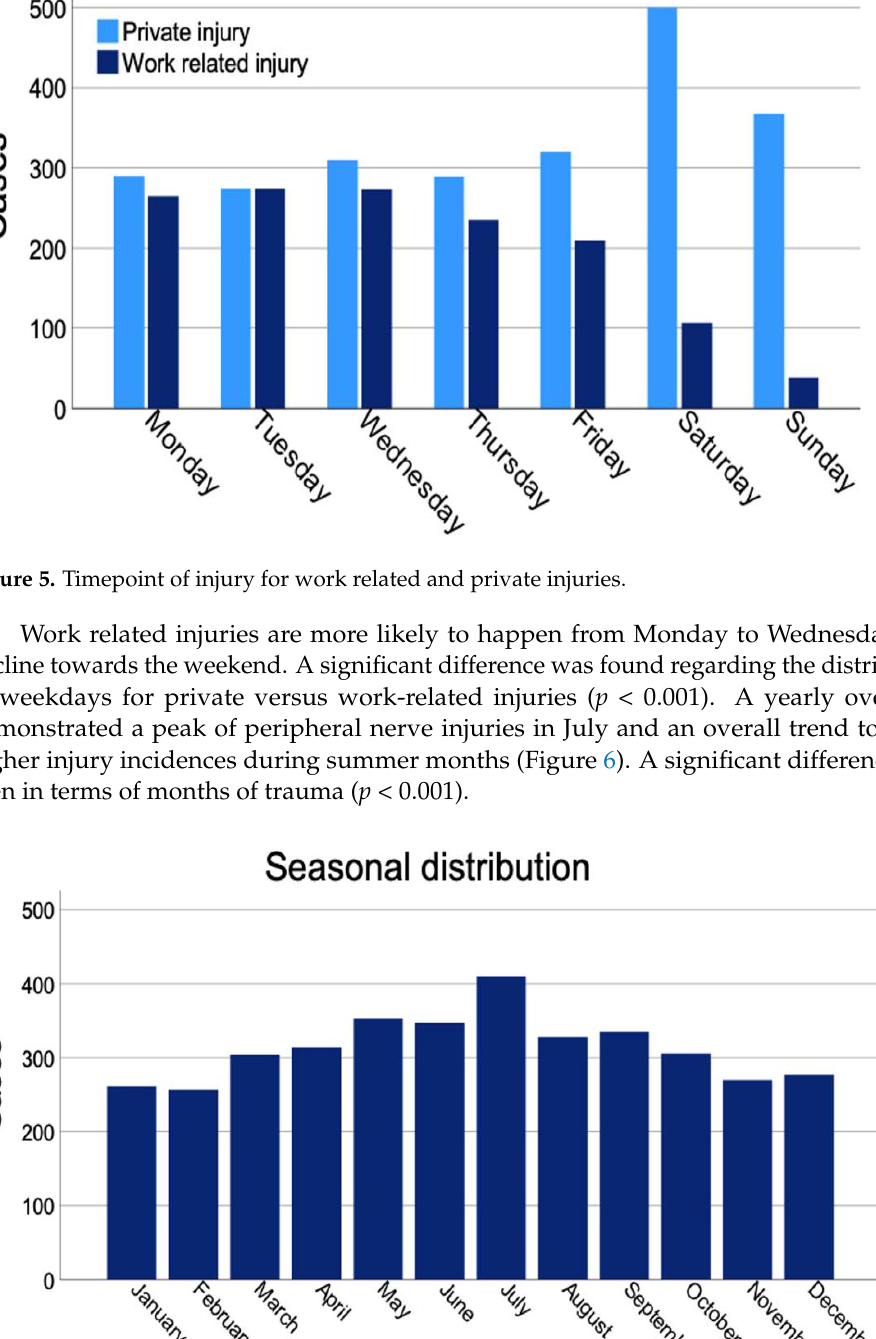
Figure 6. Seasonal distribution of all traumatic peripheral nerve injuries.